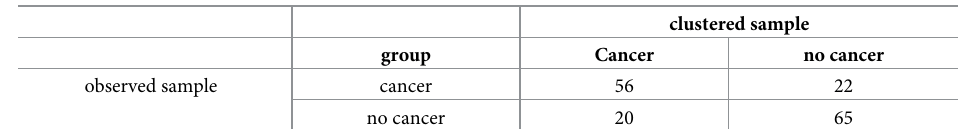
Table 1. Confusion matrix.